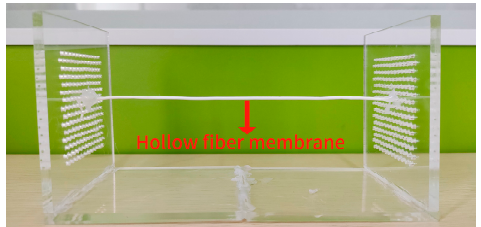
Figure 3. Hollow fiber membrane fixation module.